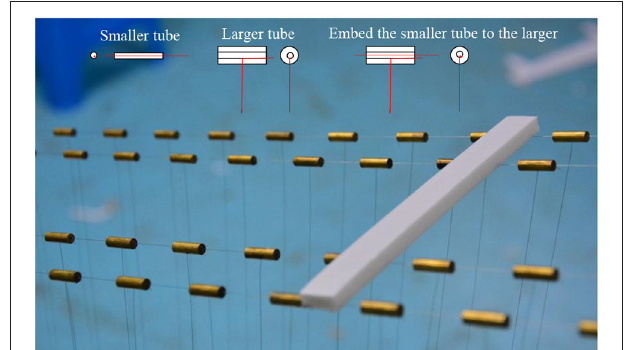
FIGURE 6 | Stiffness system of stiffening girder.